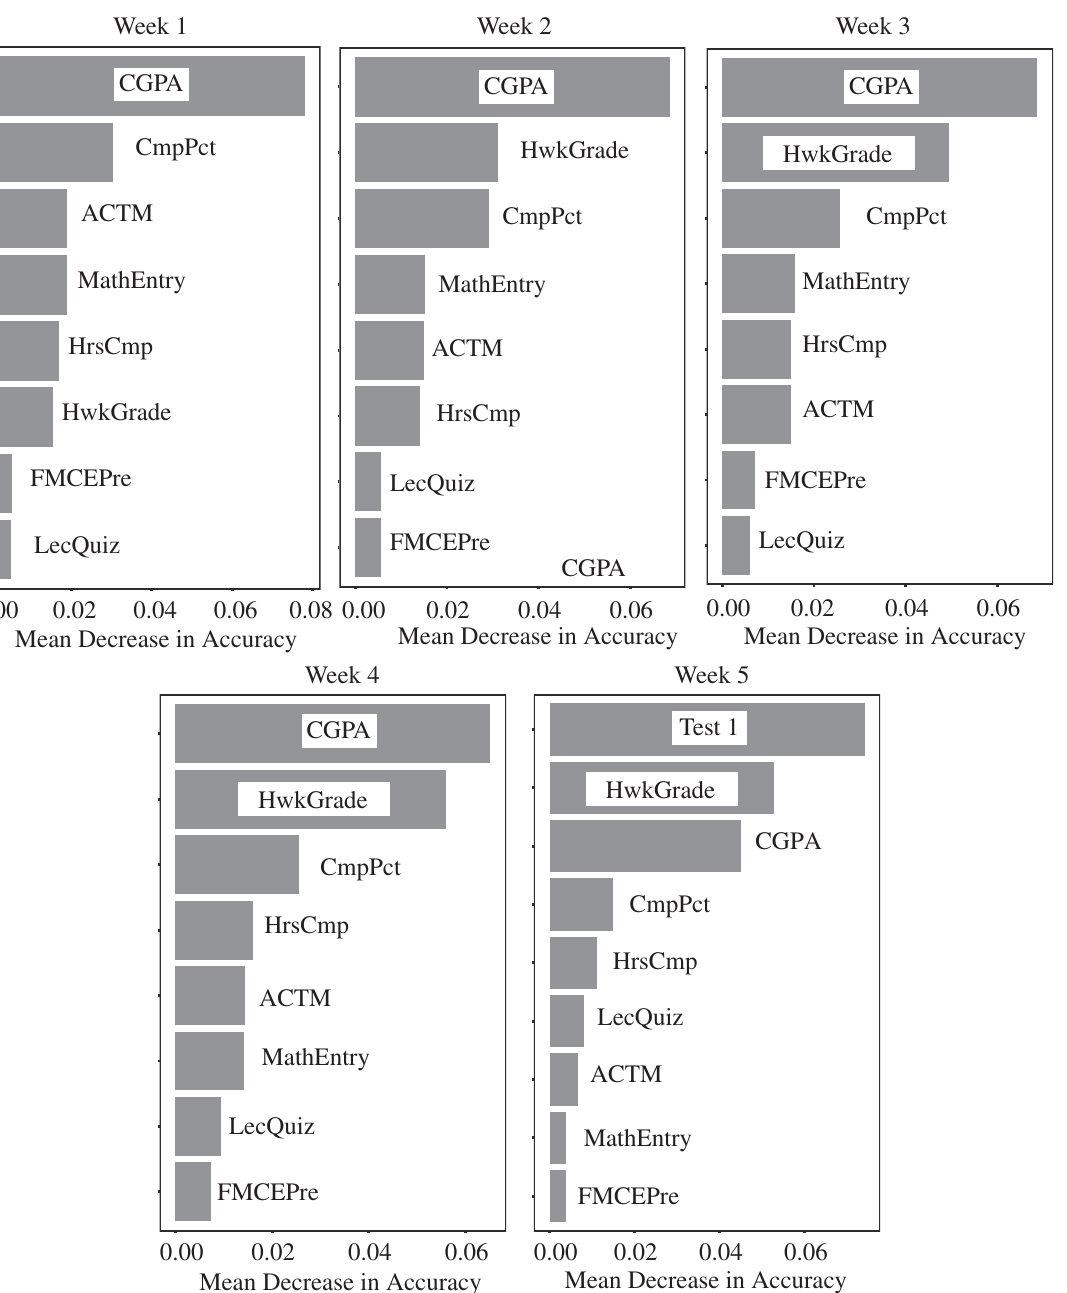
FIG. 3. Physics 1: Weekly variable importance of the combined in-class and institutional